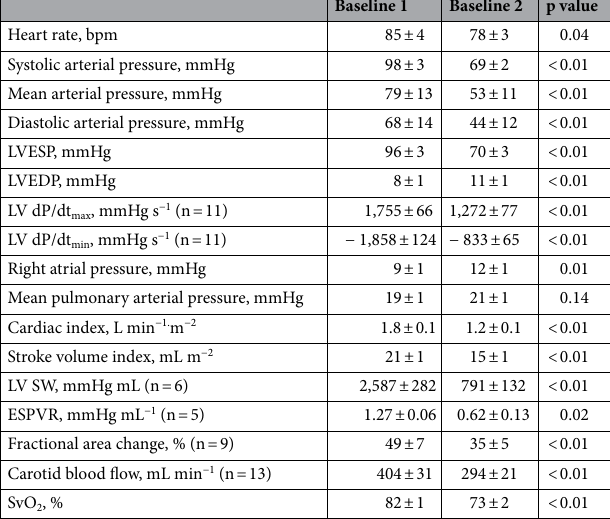
Table 1. Haemodynamic profile of cardiogenic shock (baseline 2) induced by ethanol. Data from n = 17 independent experiments (if not otherwise mentioned), expressed as mean ± SE. p value refers to comparison between baseline 1 and 2 by using a paired student’s t-test. LVESP left ventricular end-systolic pressure, LVEDP left ventricular end-diastolic pressure, dP/dt first derivative of left ventricular pressure; LVSW Left